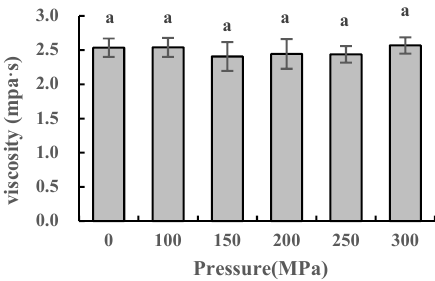
Figure 7. Apparent viscosity of skimmed milk under different pressure conditions. Different super- script letters within a column indicate significant differences between means ( p < 0.05).